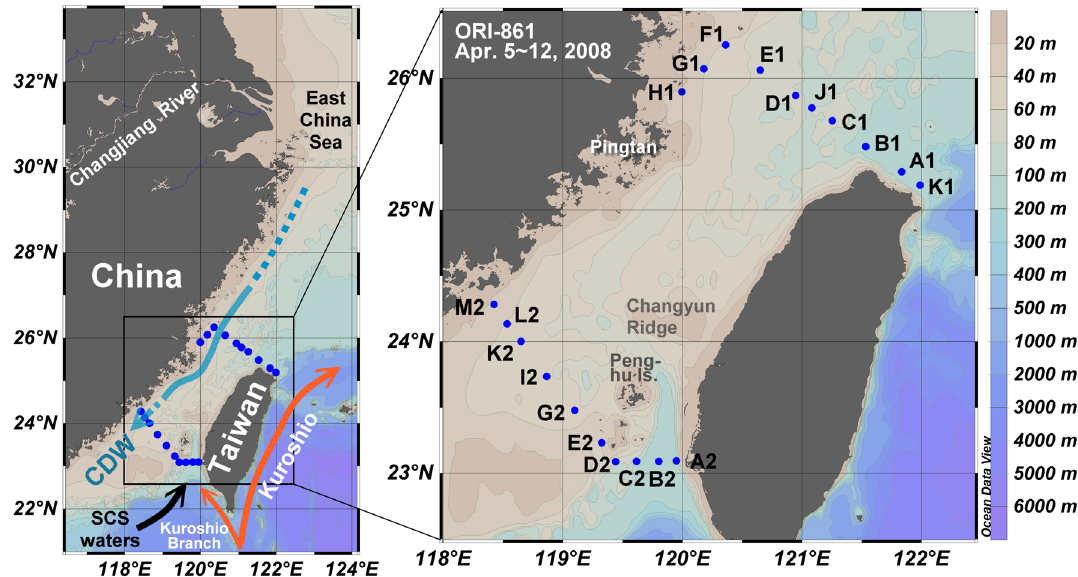
Figure 1. Study area and station locations (map generated by Ocean Data View version 5.2.1.; https ://odv.awi.